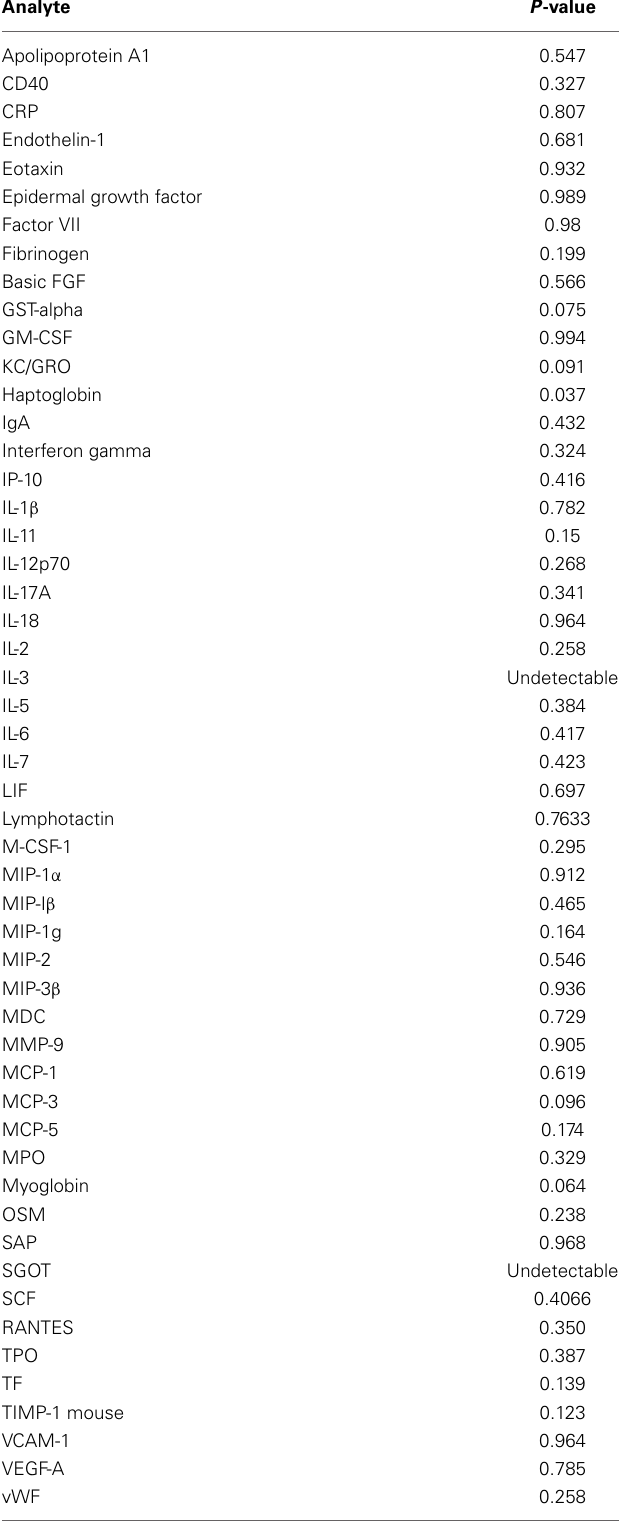
Table 1 | P -Values of BAL multiplex comparing isotype vs. anti-CD25 treated Tg + mice.